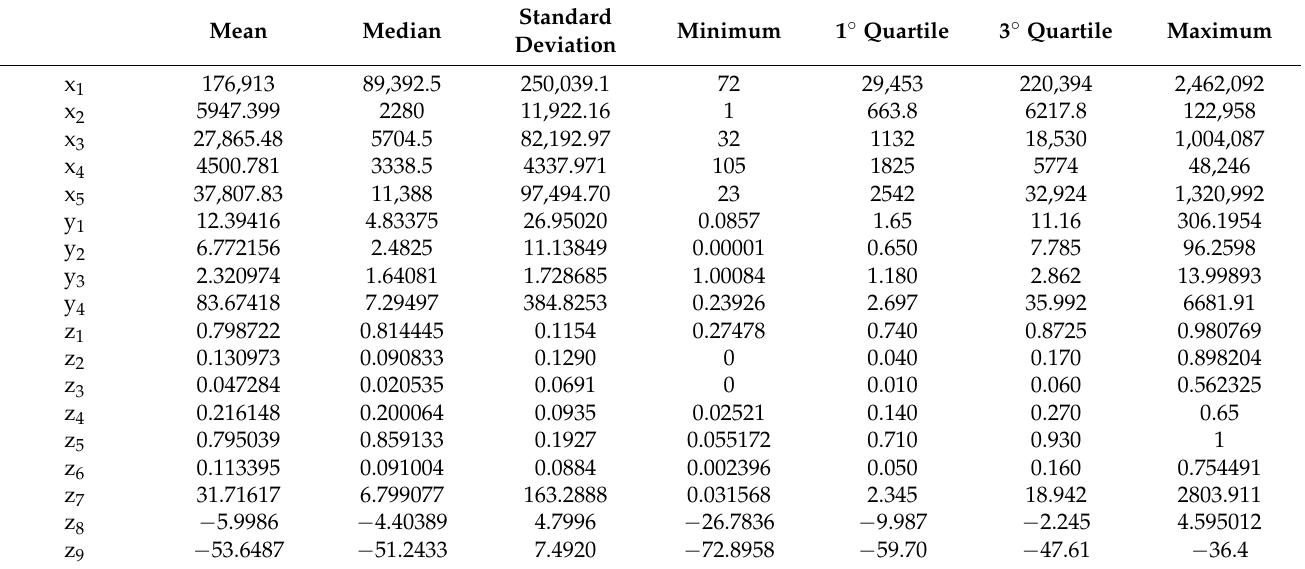
Table 1. Descriptive statistics of the inputs (x), products (y) and environmental determinants